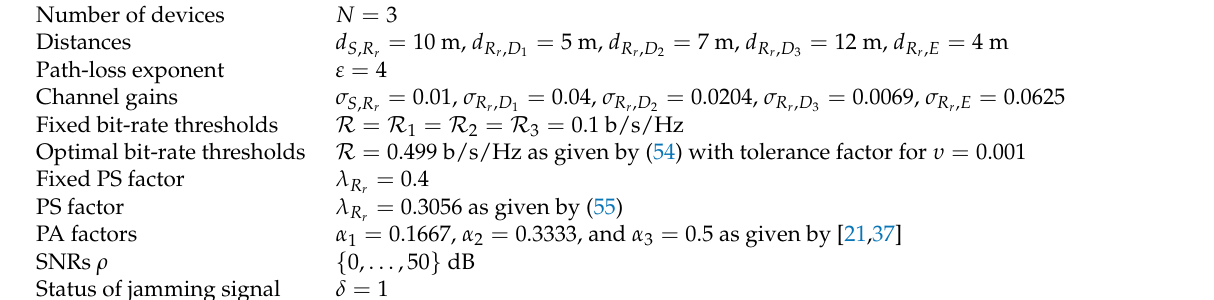
Table 2. Table of parameters (denoted r = { 1,2 }